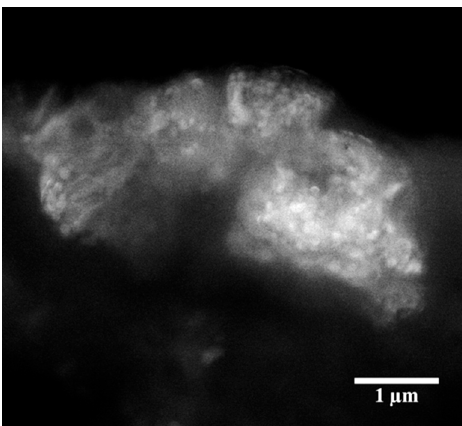
Figure 4. Scanning electron microscopy (SEM) micrograph of as-prepared Mo 15 S 19 particles showing their aggregation state prior to sonication.